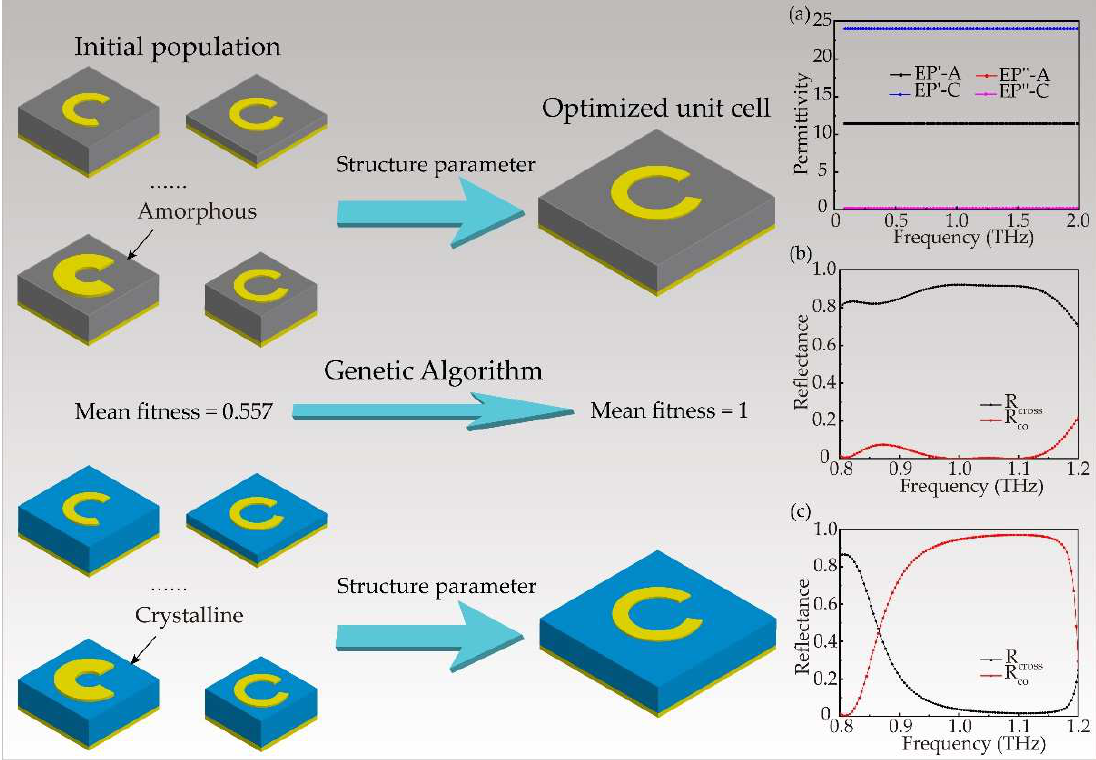
Figure 2. Schematic diagram of genetic algorithm. The genetic algorithm optimizes the CSRR unit structure with high polarization conversion efficiency and wide working band-width. ( a ) The real and imaginary parts of permittivity of GST in two states, A and C represent the amorphous and crystalline states, respectively. The simulated results of cross-polarization and co-polarization reflectance in amorphous state ( b ) and crystalline state ( c ).